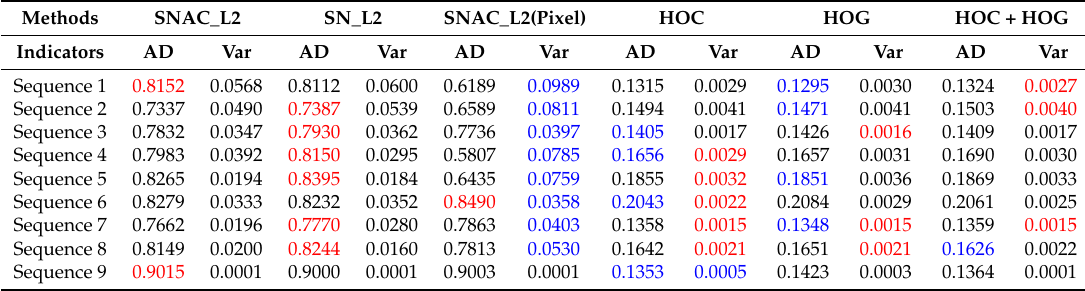
Table 2. Performance comparison of different features of detection responses. Red represents the best, and blue indicates the worst. HOC, histogram of